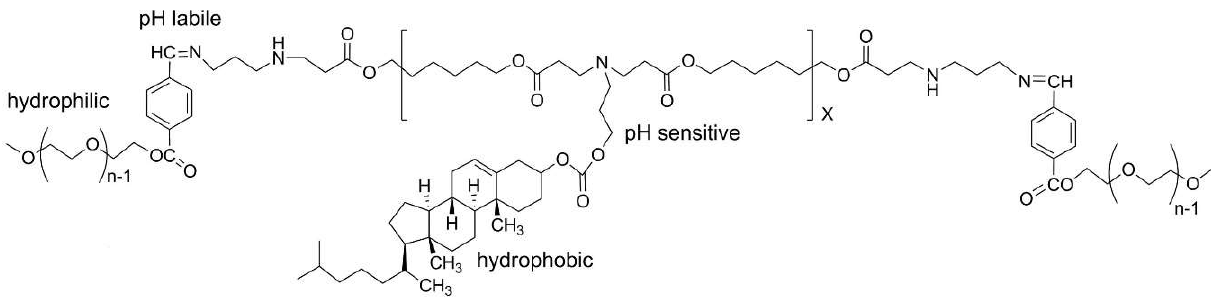
Scheme 13. Structure of bifunctional triblock polyester copolymers used for formation of nano- and